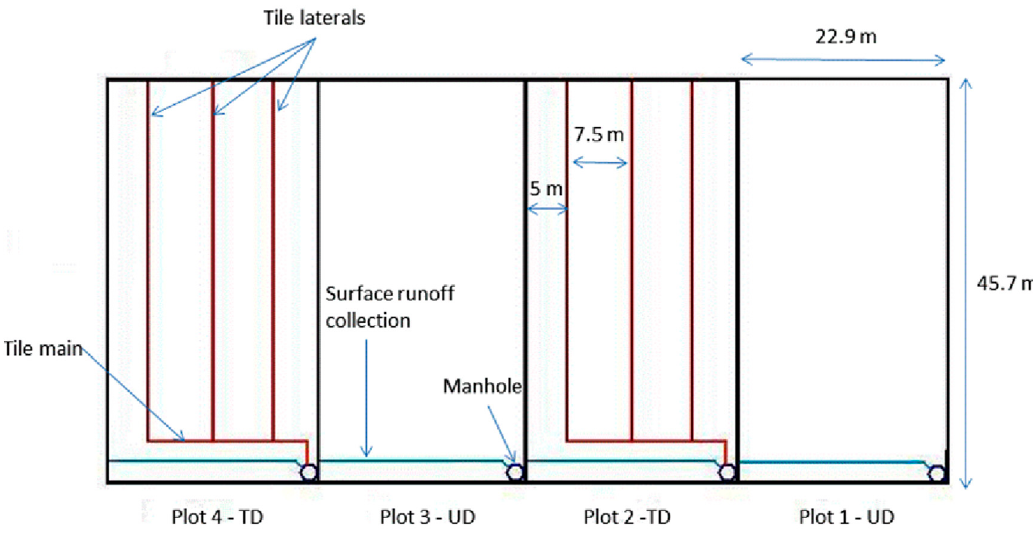
Figure 1. Schematic of tile-drained (TD) and undrained (UD) research plots.